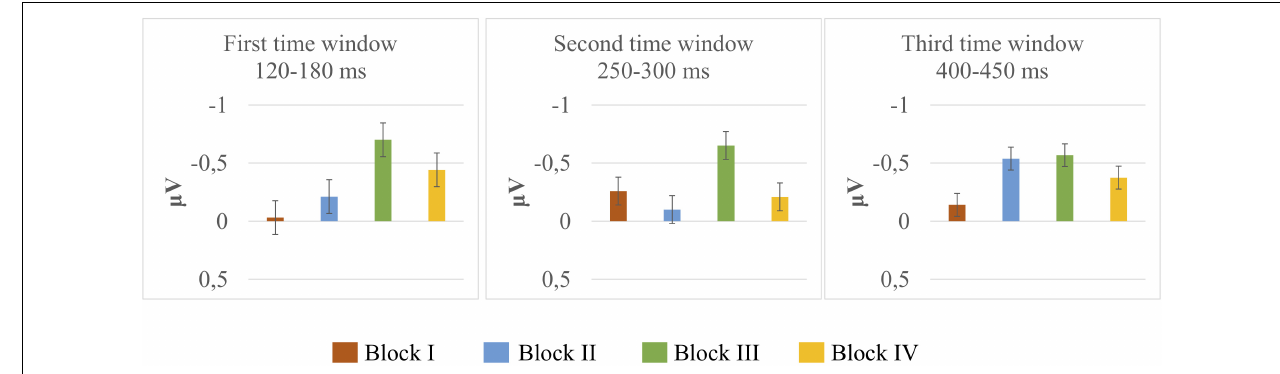
FIGURE 2 | Mean and the standard error of the mean for deviant-minus-standard subtraction amplitudes extracted from the frontal electrodes (F3, Fz, and F4) in microvolts ( µ V) of Block I (Orange bar), Block II (Blue bar), Block III (Green bar), and Block IV (Yellow bar) at three time